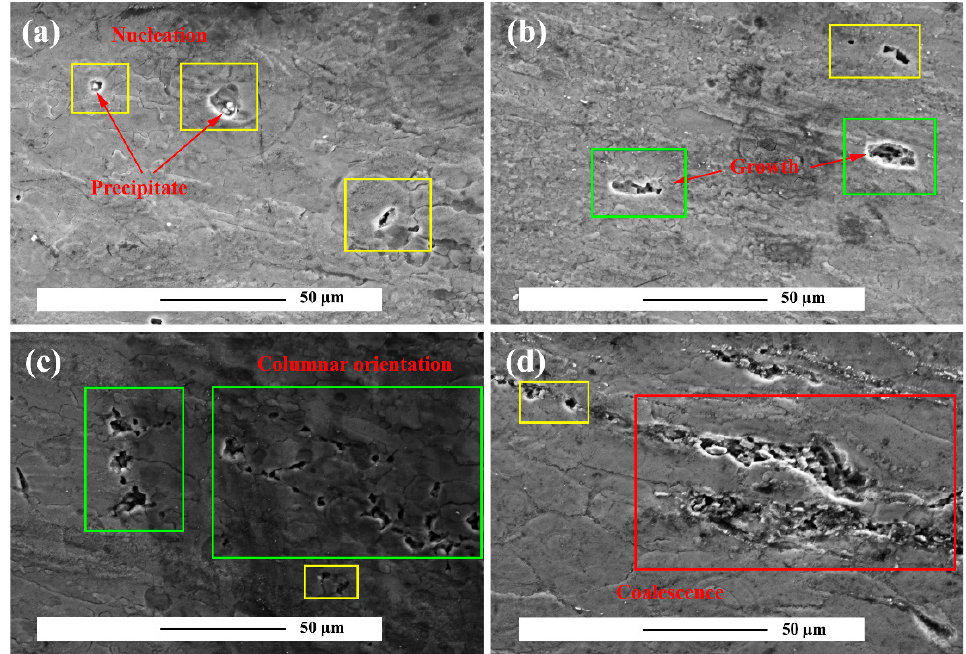
Figure 13. Cavitation stage in unreinforced alloy after creep test at 150 °C under 60 MPa stress for times of: ( a ) 72 h, ( b ) 96 h, ( c ) 120 h, and ( d ) 144 h.